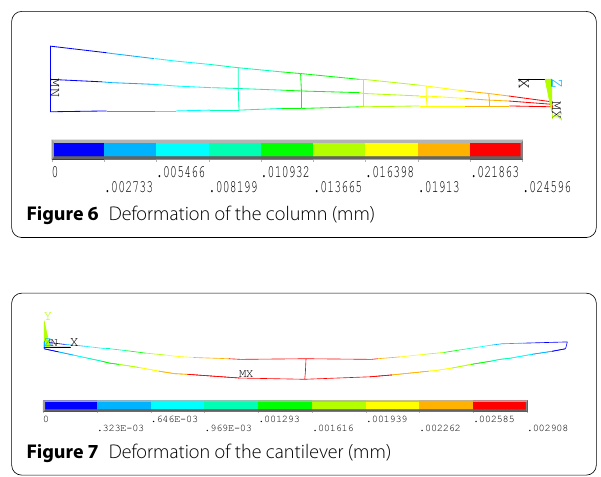
Figure 8 Forces of the wall-climbing